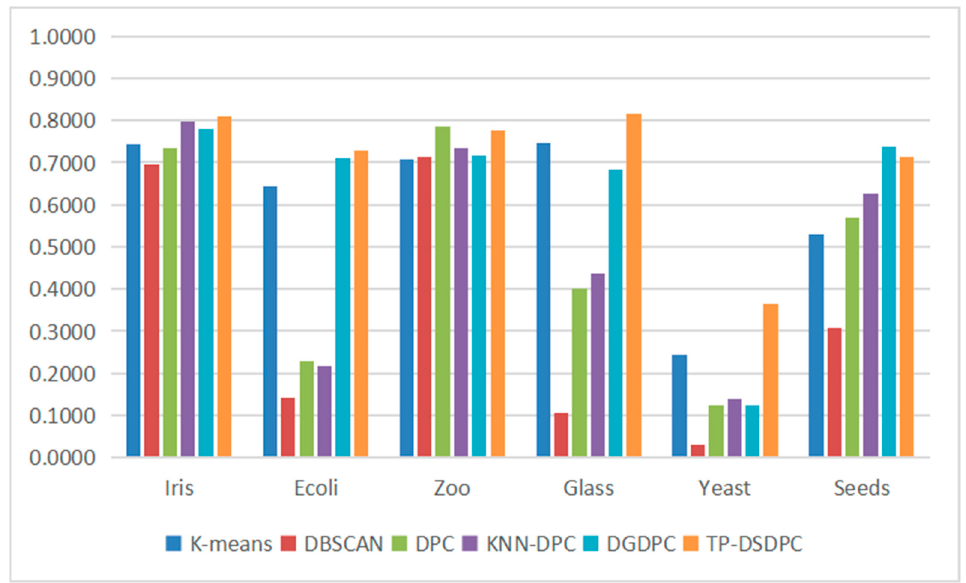
Figure 15. The NMI of the six algorithms on six real-world datasets.